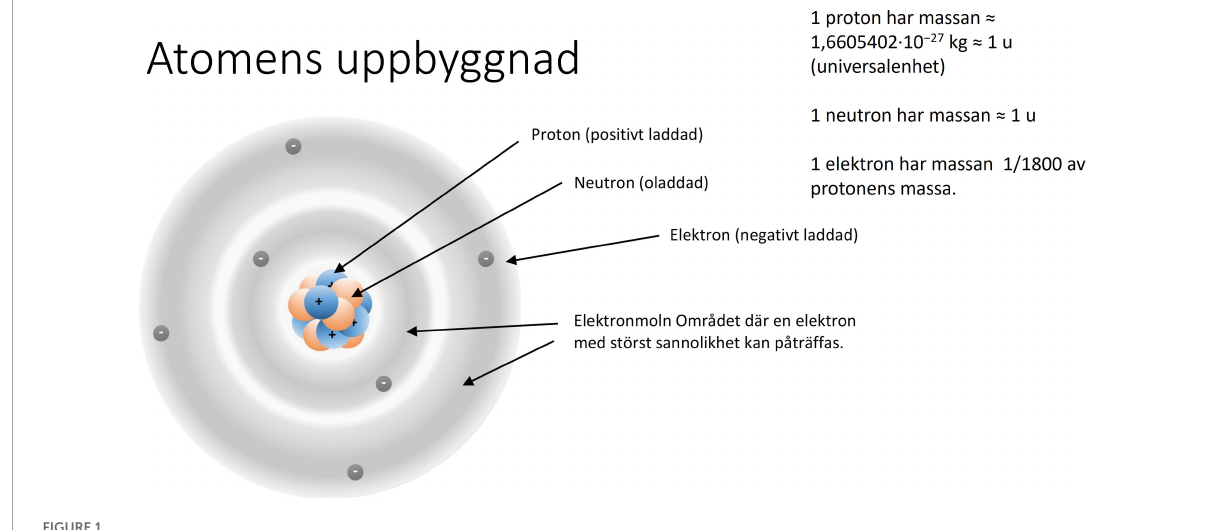
FIGURE1 The teaching model used for the students included in this study.